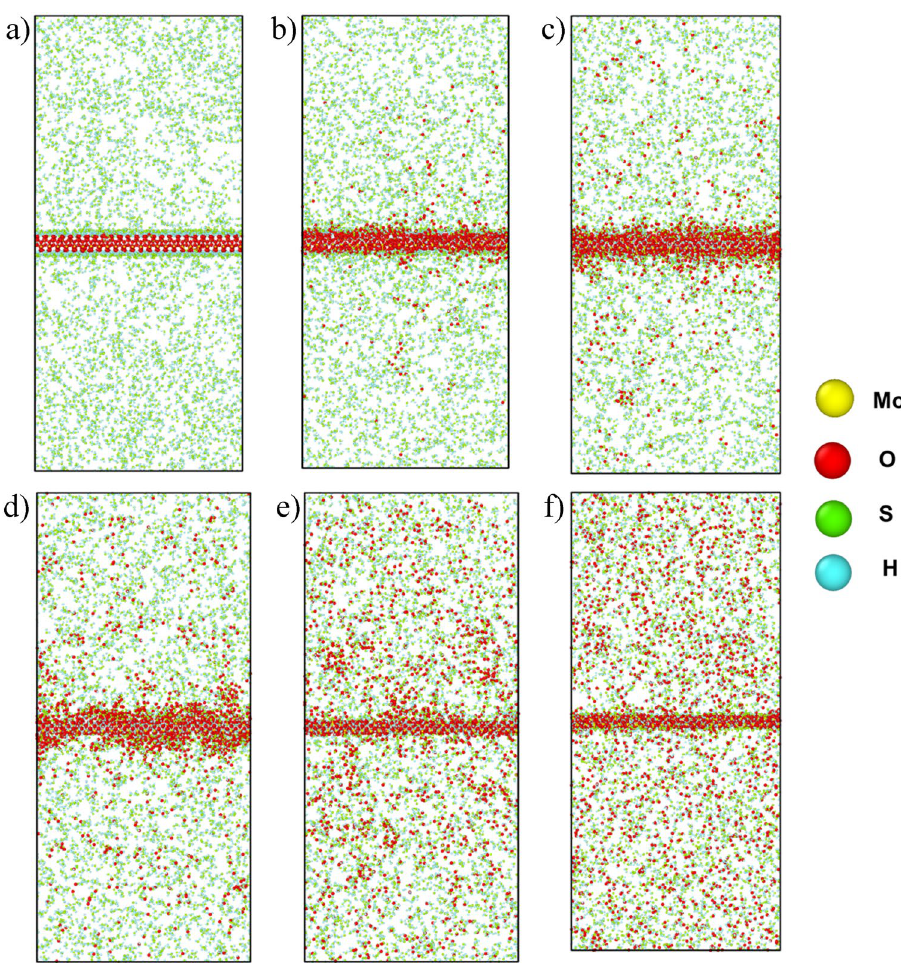
Figure 6. Snapshots of the simulation system at ( a ) 25 ps, ( b ) 95 ps, ( c ) 165 ps, ( d ) 235 ps, ( e ) 305 ps, and ( f ) 375 ps where the surface compositions were MoO 2.99 S 0.03 H 0.05, MoO 2.84 S 0.21 H 0.55, MoO 2.65 S 0.52 H 1.30 , MoO 2.47 S 0.48 H 1.40 , MoO 1.94 S 0.24 H 1.36 , and MoO 1.72 S 0.33 H 1.37 ,